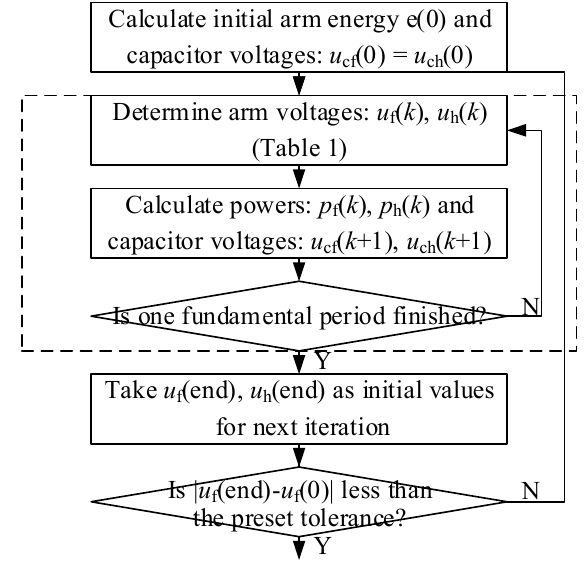
Figure 7. Computing process of capacitor voltages.